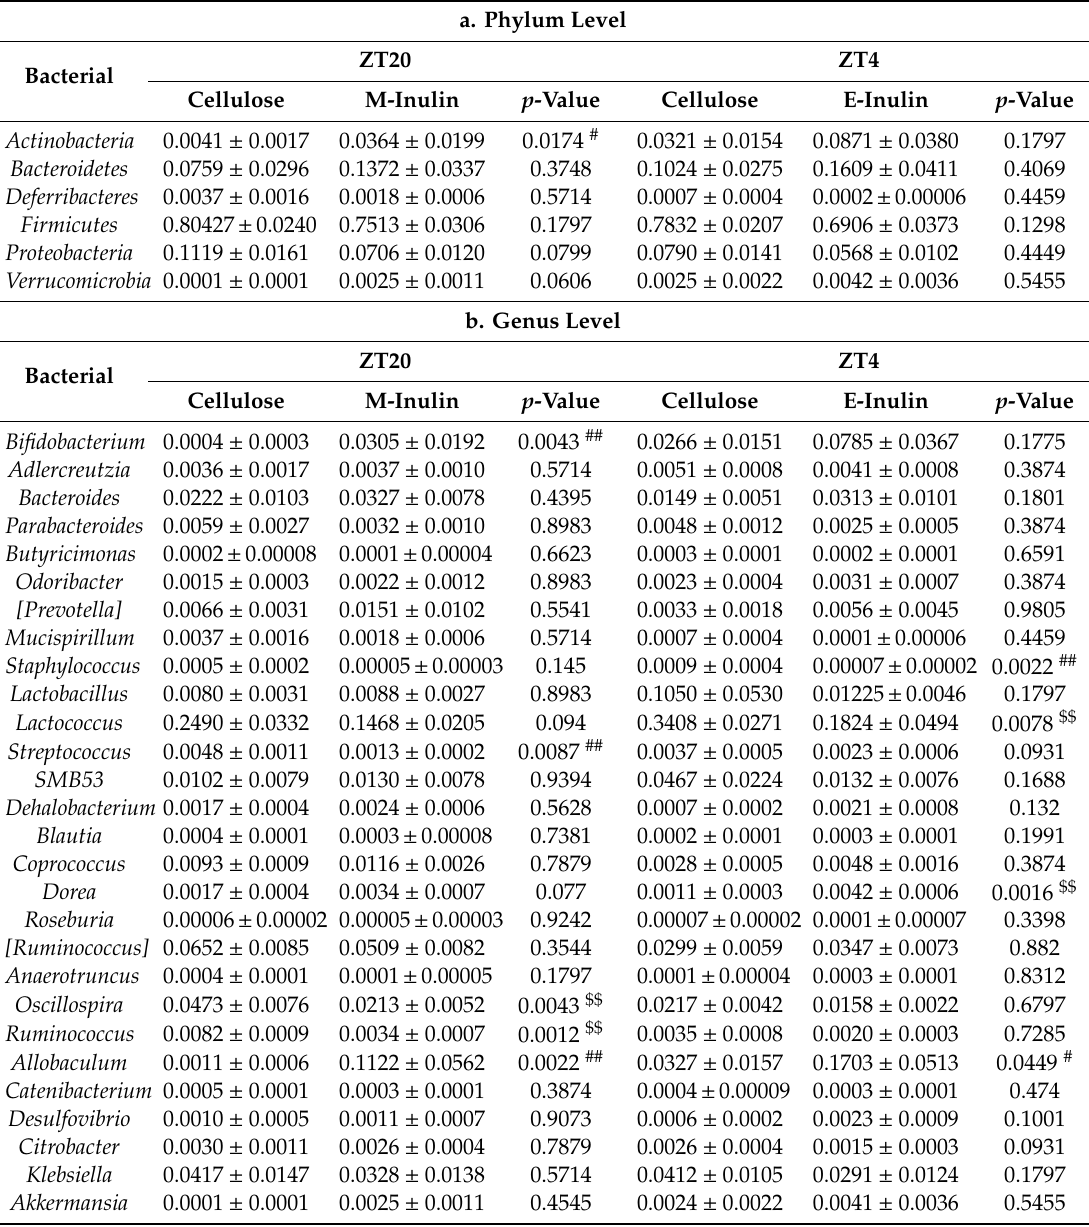
Table 2. The relative abundance of some bacteria under the condition of one meal per day. ( a ). Phylum level. ( b ). Genus